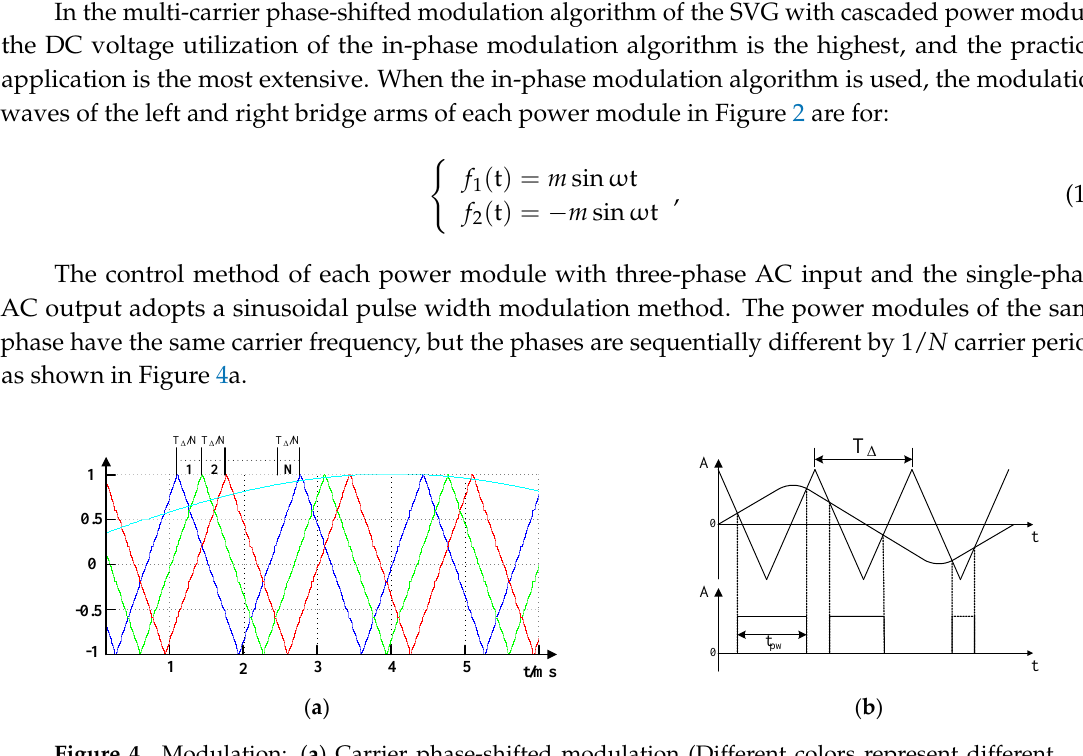
( b ) Figure 5. Pulse control signal calculation principle: ( a ) S 11 ; ( b ) S 13 . In Figure 5a, θ i is the angle value of the midpoint sampling time of the triangular wave. 1 (1